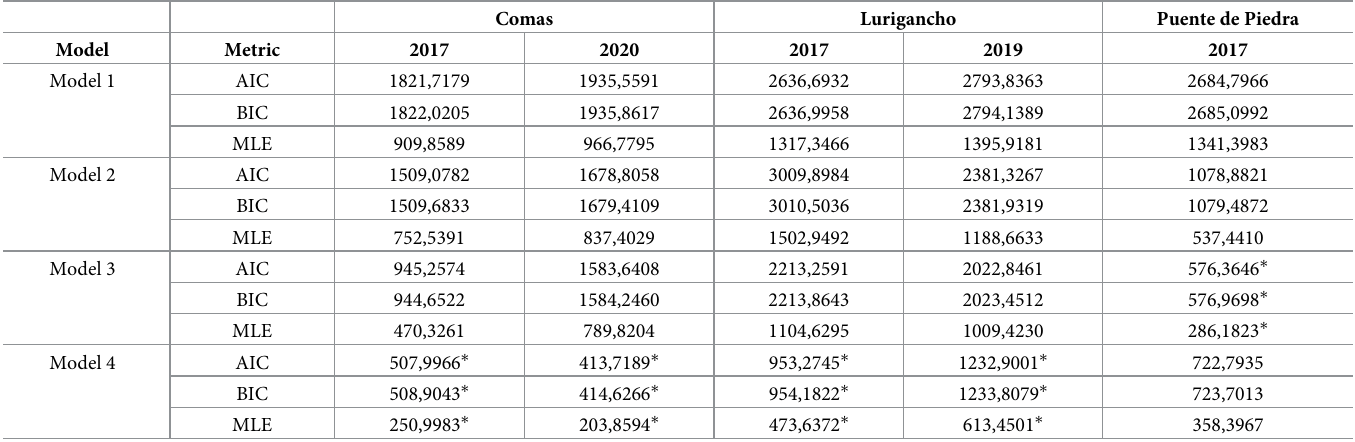
Table 6. AIC, BIC, and MLE values for each